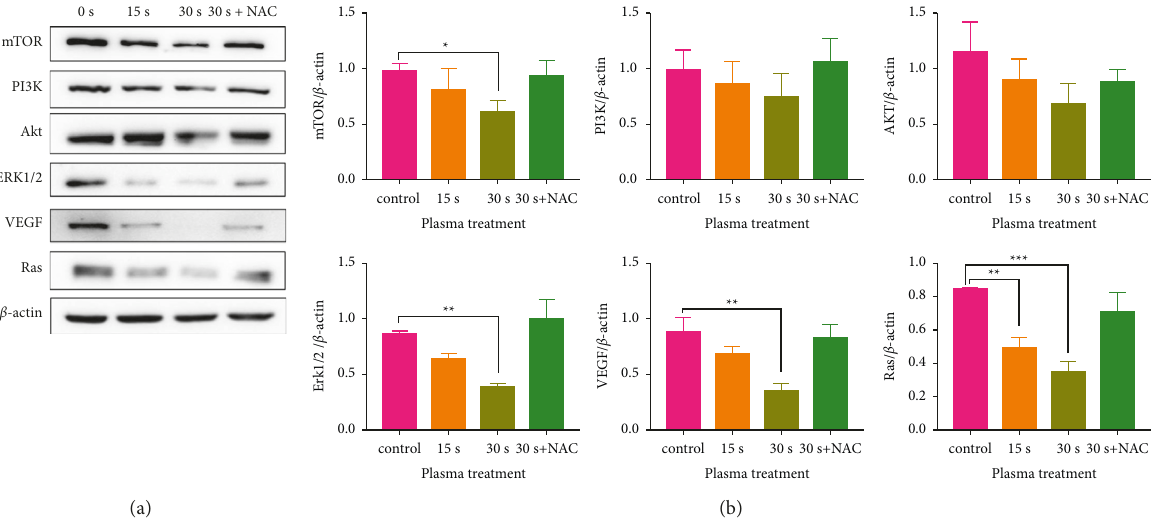
Figure 7: CAP treatment-induced changes in protein expression levels. (a) CAP affected the expression of PI3K, Akt, mTOR, Erk1/2, VEGF, and Ras. (b) The quantification by measuring the protein expression with ImageJ software.